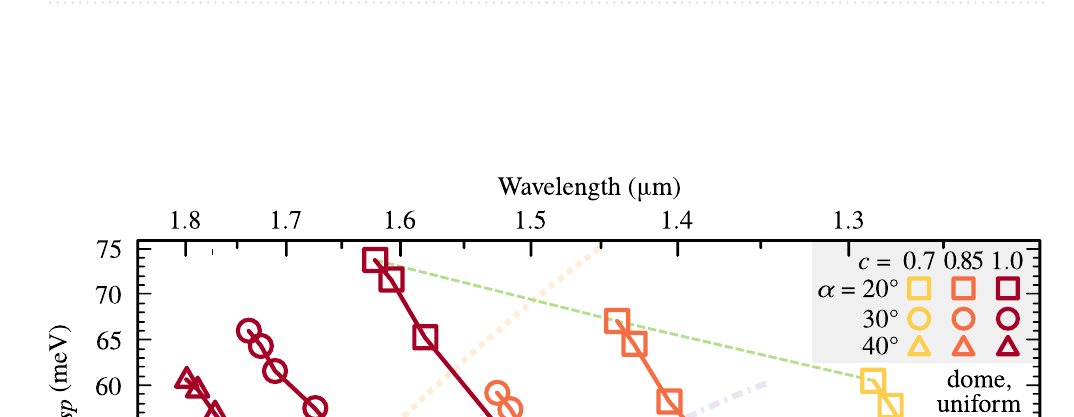
Figure 5. Energy splittings in InAs/AlGaInAs QDs. Dependence of the s – p shell energy splitting on the ground-state energy for InAs/AlGaInAs QDs of two base sizes (coded by the symbol type), three values of 30 InAs concentration c (color), and with α ◦ . Solid lines are to guide the eye over series differing in QD = height varied by 1 nm in ranges marked by labels. The dashed line connects an exemplary set of results for fixed geometry and varying c . Thick dotted and dash-dotted pale lines show the trends for the uniform change of size of a full and truncated pyramidal QDs, respectively.